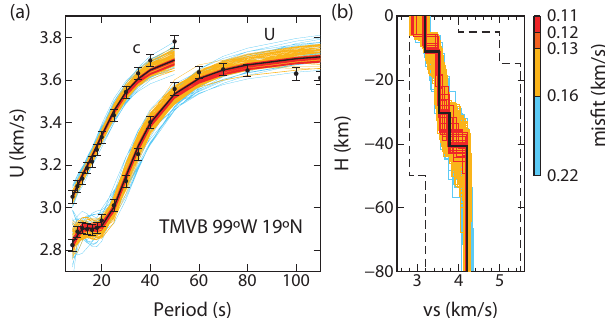
Figure 8. Example of 1-D inversion of phase and group veloc- ity at one node of the grid situated on the TMVB. (a) Dispersion curves (group and phase) obtained from the combination of ANT and earthquake based tomography (circles). Their error bars are cal- culated as the resolution of the tomography on this node and period normalized by a factor of 2500 (inkm). Accepted models are shown as colored lines, and the best fitted dispersion curves as black lines. (b) Dashed lines show the feasible region in the inversion; the col- ored lines are the models with misfits less than or equal to two times the best fitting (0.11kms − 1 ); and the black line indicates the shear- velocity model that best fits the observed dispersion curves. The scale shows the color code of the